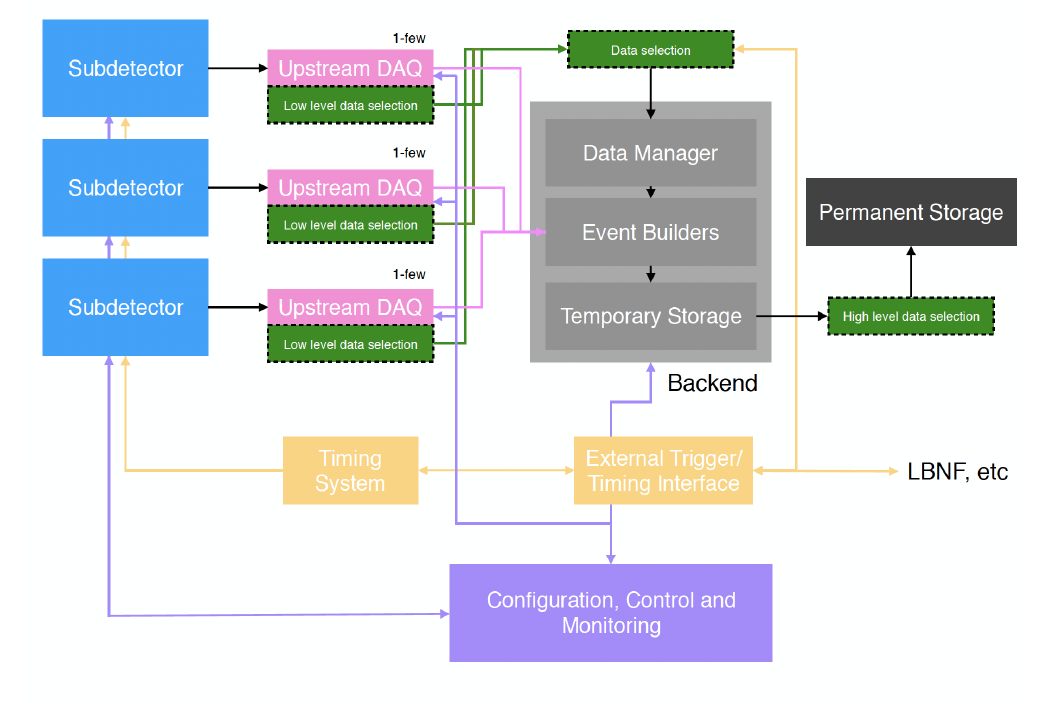
Figure 186. A simplified diagram of the reference ND DAQ design. Subdetector systems are shown in blue, the upstream DAQ in pink, the data selection system in green, the backend in grey, the timing in orange, and the control system in